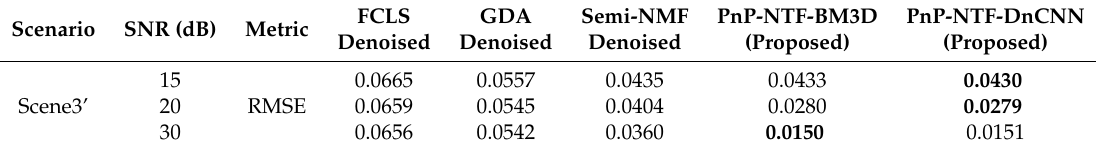
Table 6. Evaluation result of denoised abundance in ’Scene3’ with different